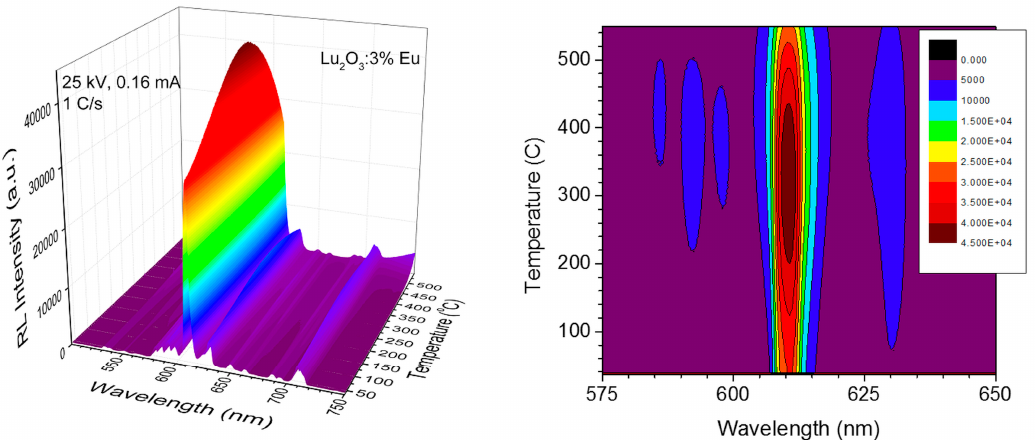
Figure 7. Temperature dependence of X-ray excited radioluminescence (RL) in Lu 2 O 3 :Eu NP in the 30–500 K range.